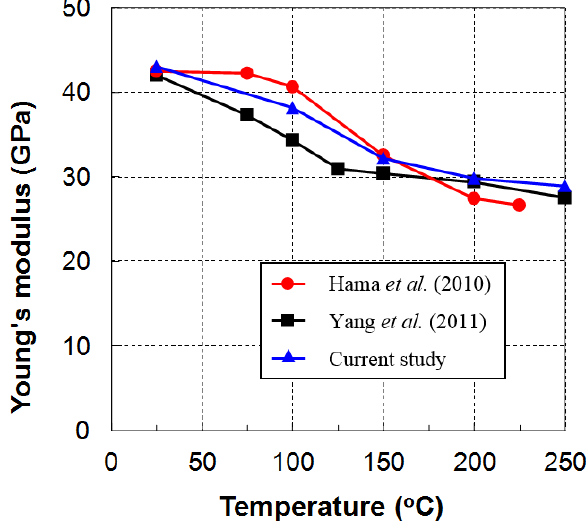
Figure 9. Variation of Young’s modulus with